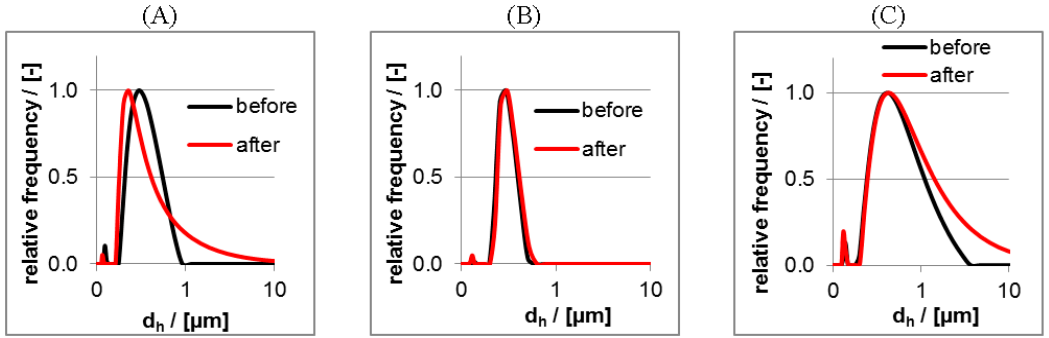
Figure 4. Intensity weighted size distributions from dynamic Light Scattering (DLS) measurements on dispersions of PLL/CS-3.0 ( A ); PLL/CS-1.0 ( B ) and PLL/CS-0.5 ( C ) (all PEC 0.9 samples).